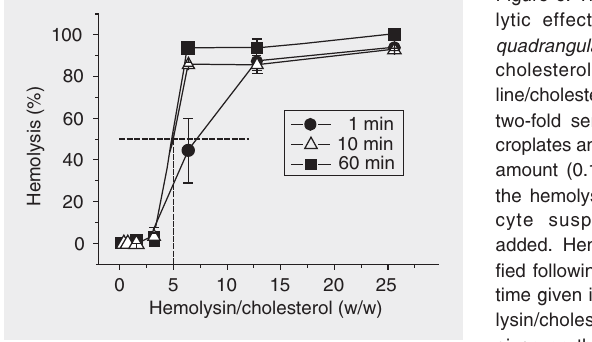
row indicates a condition in which 50% inhibition of hemolysis was observed. Data are reported as mean ± SD percent hemolysis for 4 experiments. Circles = 1 min; triangles = 10 min; squares = 60